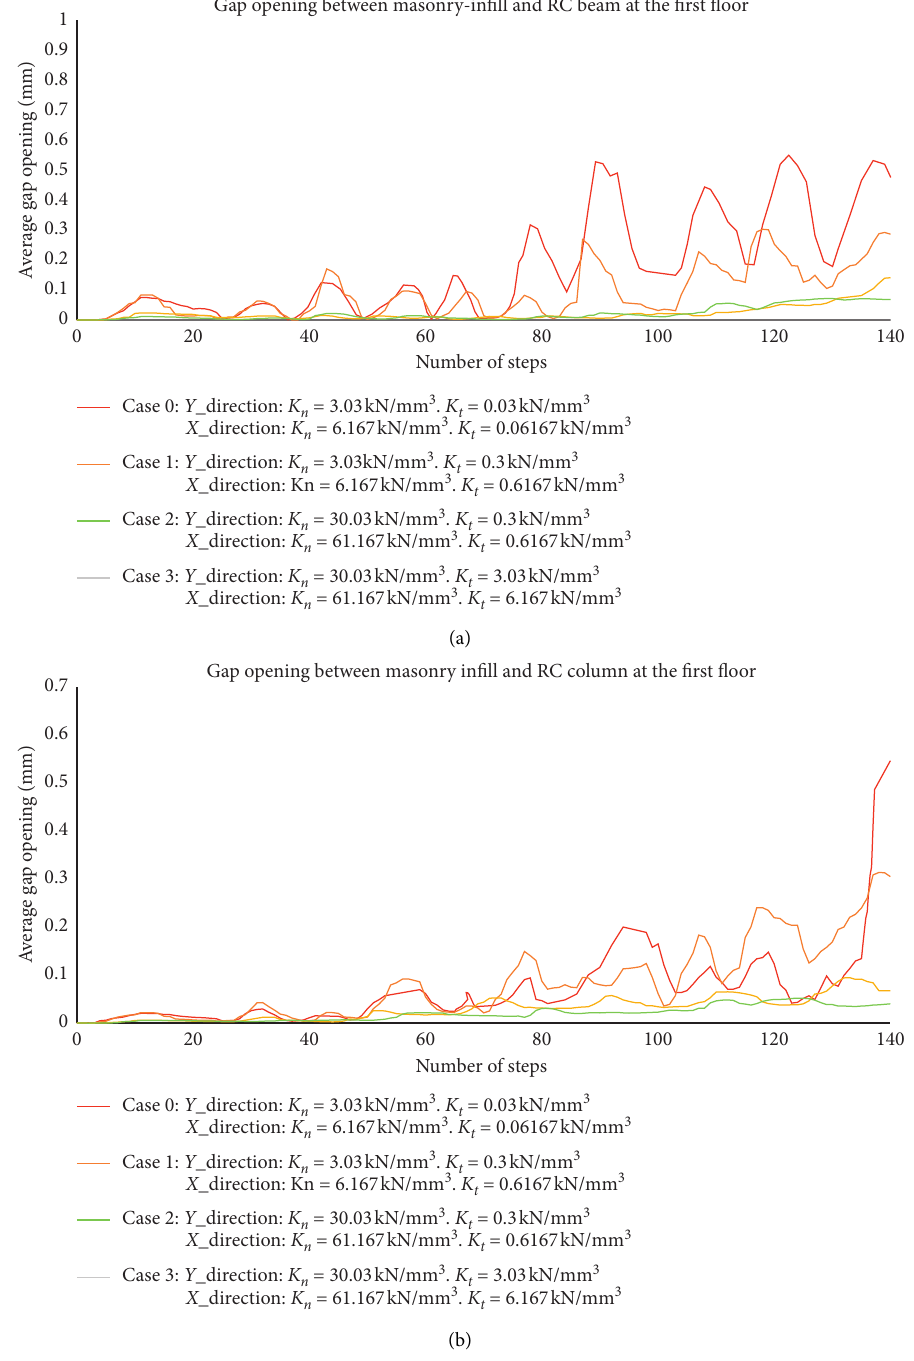
Figure 11: Comparison between numerical model results using different values in the stiffness of the interface for the TRM masonry-infilled frame in terms of gap opening between the masonry infill and (a) the beam and (b) the